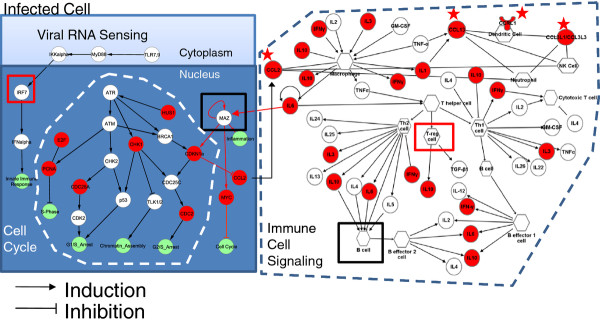
Differential response network between CA04- and KUTK4-infected lung tissue. Highly enriched canonical pathways identified by using IPA (namely, ‘Role of CHK Proteins in Cell Cycle Checkpoint Control’, enclosed by the white, broken line and ‘Role of Cytokines in Mediating Communication between Immune Cells’, enclosed by the blue broken line) were integrated by using highly enriched transcription factors and IPA's Expert Curated protein-protein interaction database. Newly identified interactions which are not part of the canonical pathways are illustrated with red arrows, whereas interactions belonging to the canonical pathways are colored black. Proteins that are differentially up-regulated in CA04-infected lung tissue relative to KUTK4-infected lung tissue on day 7 p.i. are colored red. Three chemokines and one chemokine receptor which were up-regulated in the CA04 infection on day 3 as well are demarcated by red stars adjacent the protein. Transcription factors or cell types for which the transcription factors surrogate as cell markers are boxed in red or black representing enrichment on day 3 or day 7 p.i., respectively.